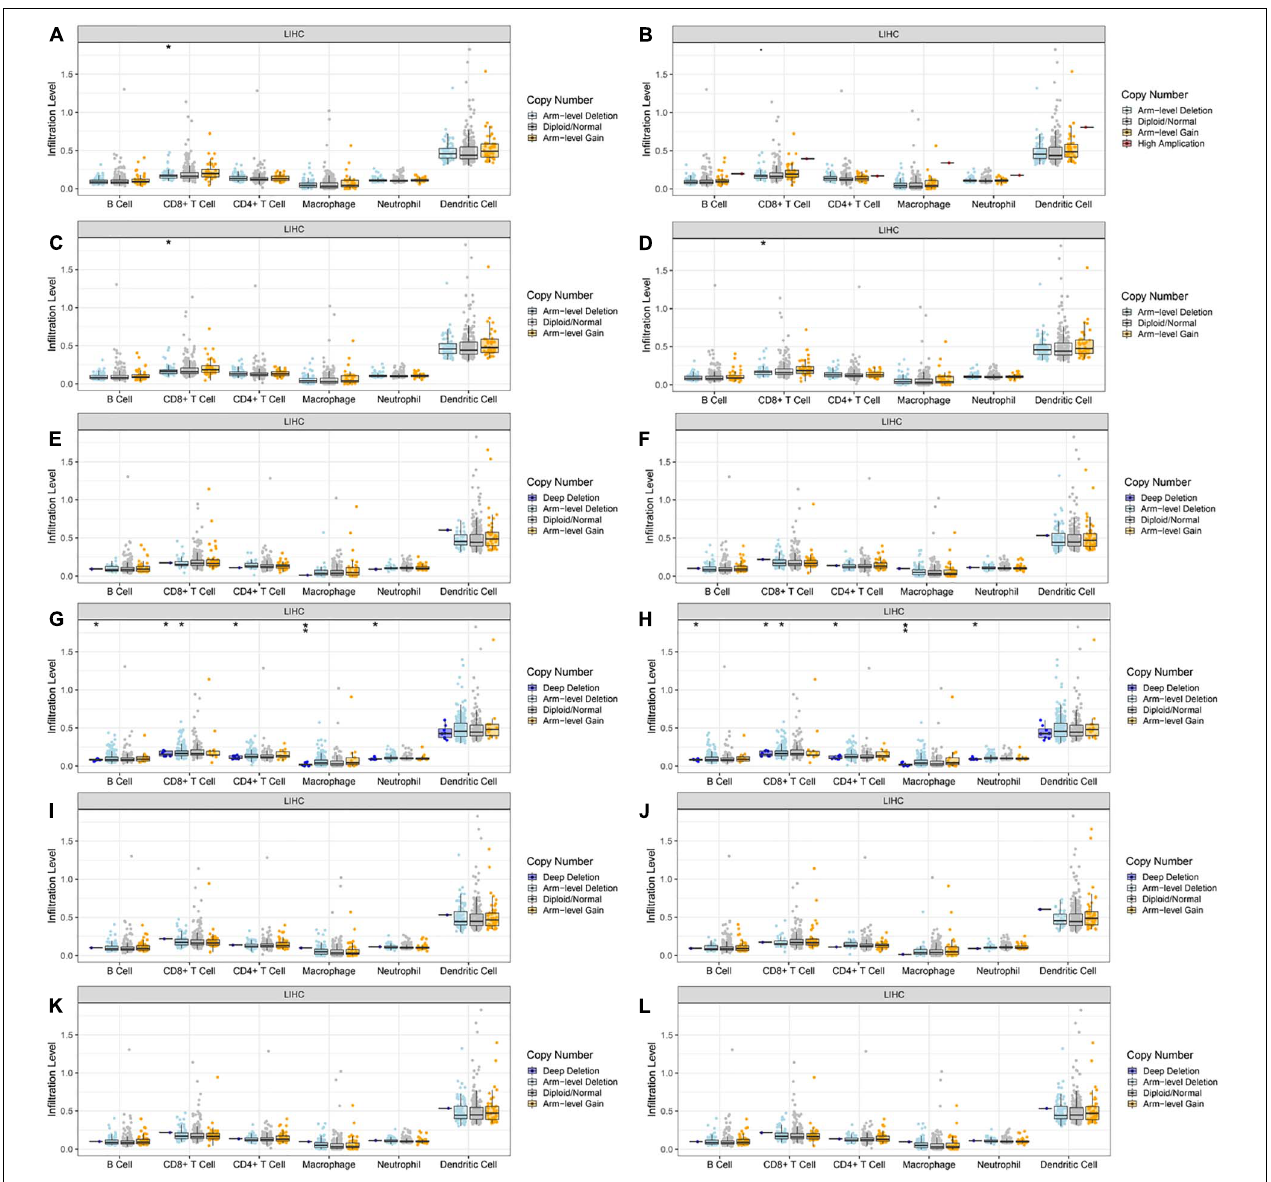
FIGURE 9 | The connection between the copy number variation (CNV) of CLEC4s and the immune cell infiltration level in HCC. (A) CLEC4A, (B) CLEC4C, (C) CLEC4D, (D) CLEC4E, (E) CLEC4F, (F) CLEC4G, (G) CLEC4H1, (H) CLEC4H2, (I) CLEC4J, (J) CLEC4K, (K) CLEC4L, and (L) CLEC4M. ** p < 0.01; * p <